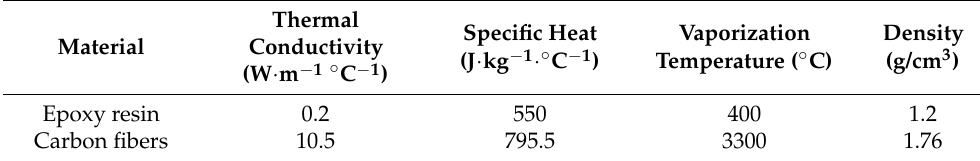
Table 1. The thermos-physical parameters of